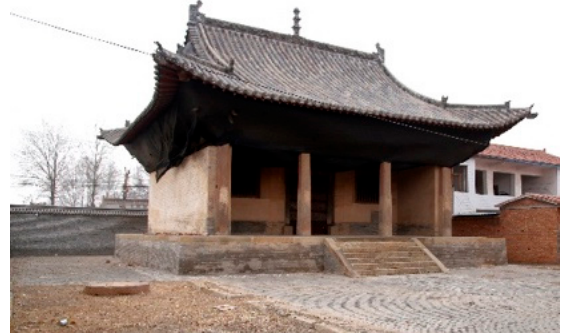
Figure 1. The Jin Dynasty main hall of this temple was restored in 2012 but has remained unused and locked up since then. It is experiencing leaking and animal infestation by the time of the fieldwork in 2018. (© Lui